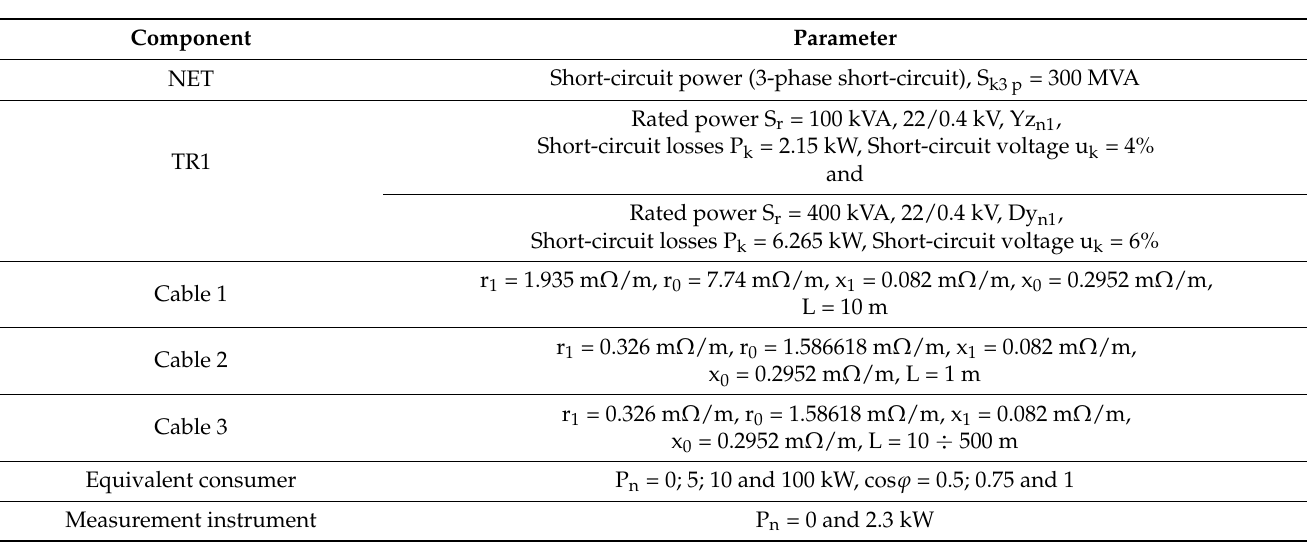
Table 4. Purely resistive